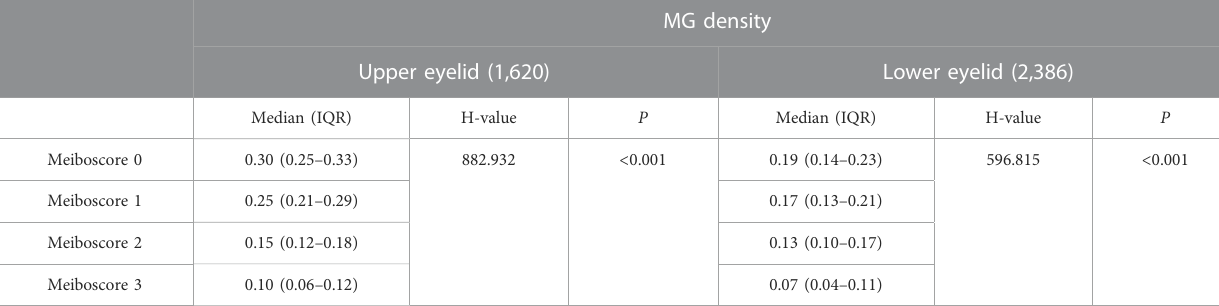
TABLE 5 Comparison table of MG density and meiboscore (Zhang et al., 2022b).